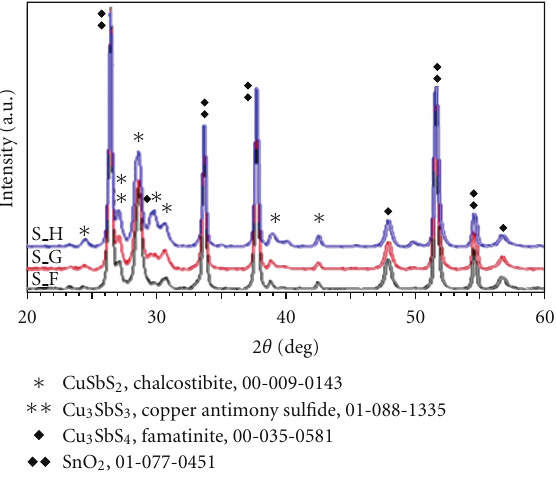
Figure 2: XRD spectra recorded for samples F, G,